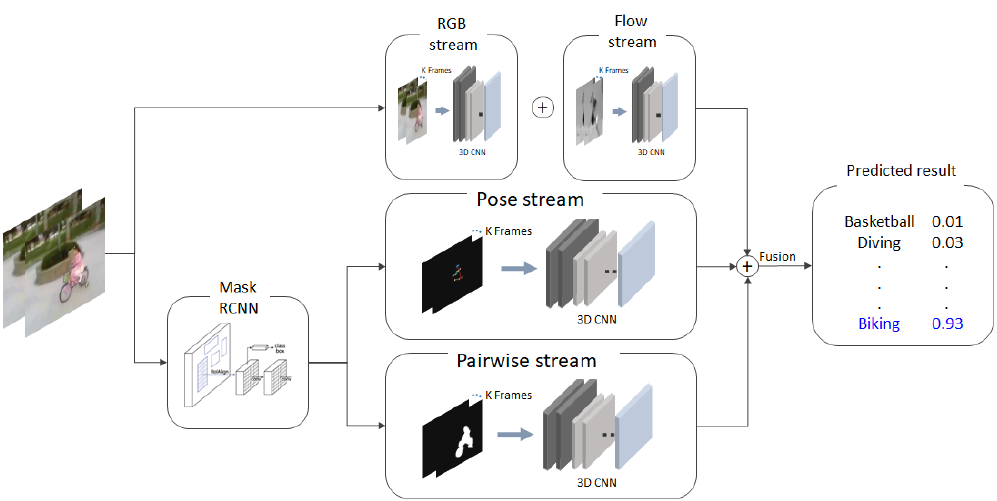
Figure 2. Overall architecture of the proposed